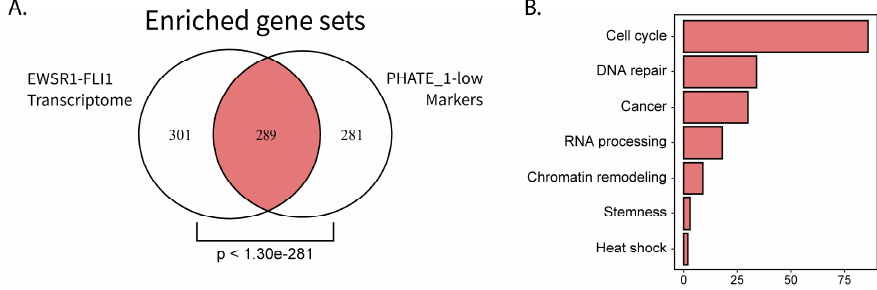
Figure 5. Comparative pathway enrichment reveals potential characteristics of EWSR1-FLI1 permissibility: ( A ) Venn diagram comparing pathway enrichment results for EWSR1-FLI1 transcriptome and PHATE_1-low gene markers (hypergeometric test p value displayed); ( B ) Bar